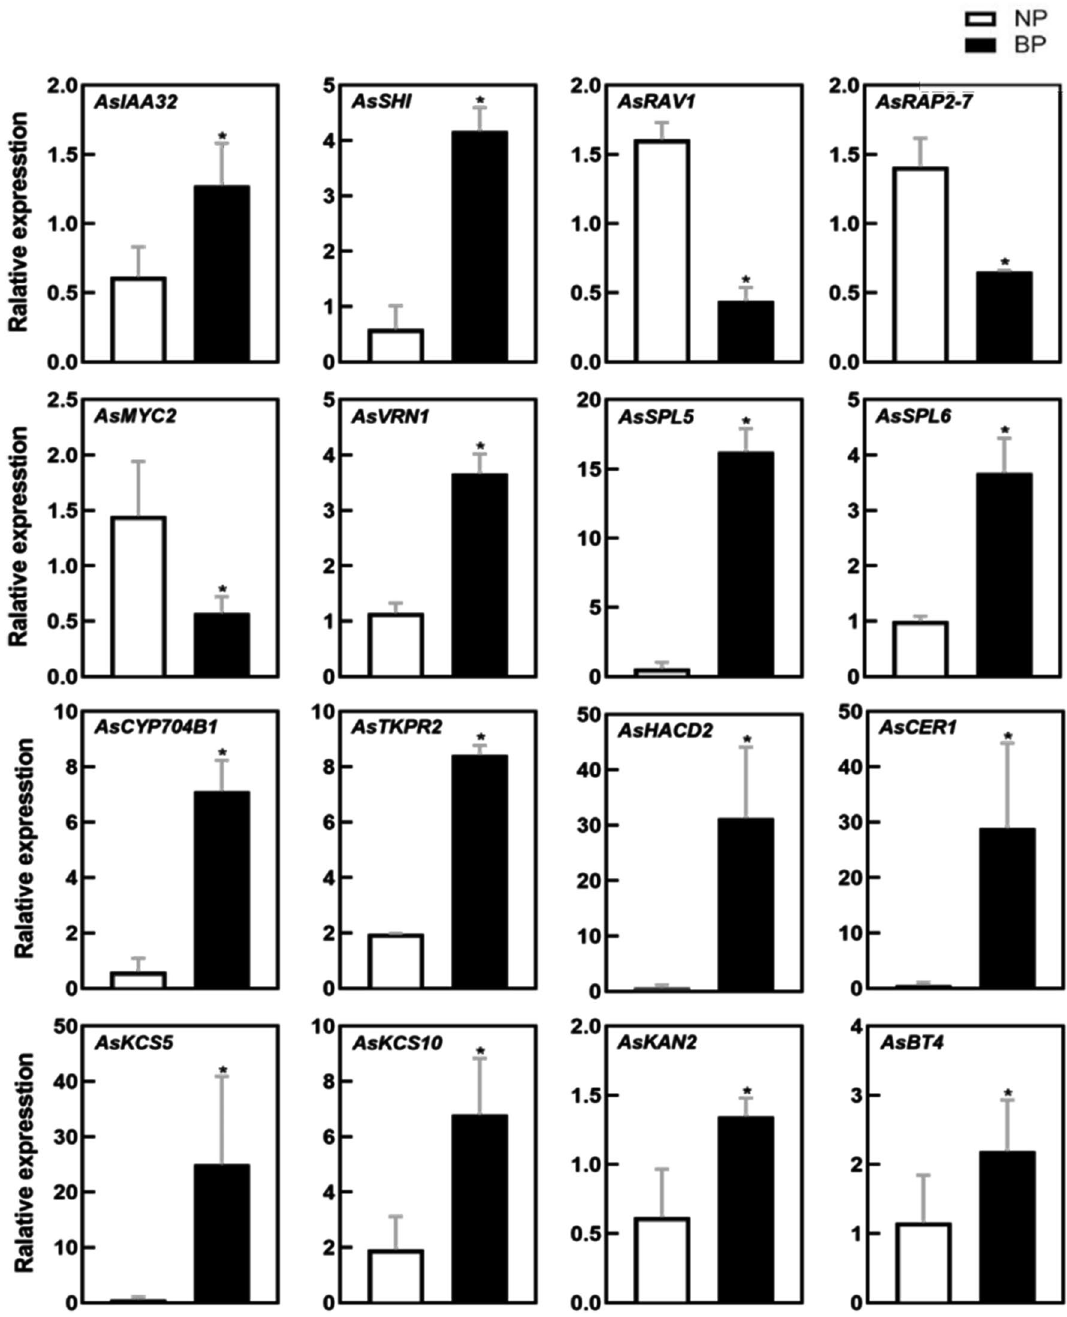
as control. * Means differed significantly ( P < 0.05). Relative expression levels were calculated using the 2 −ΔΔCT